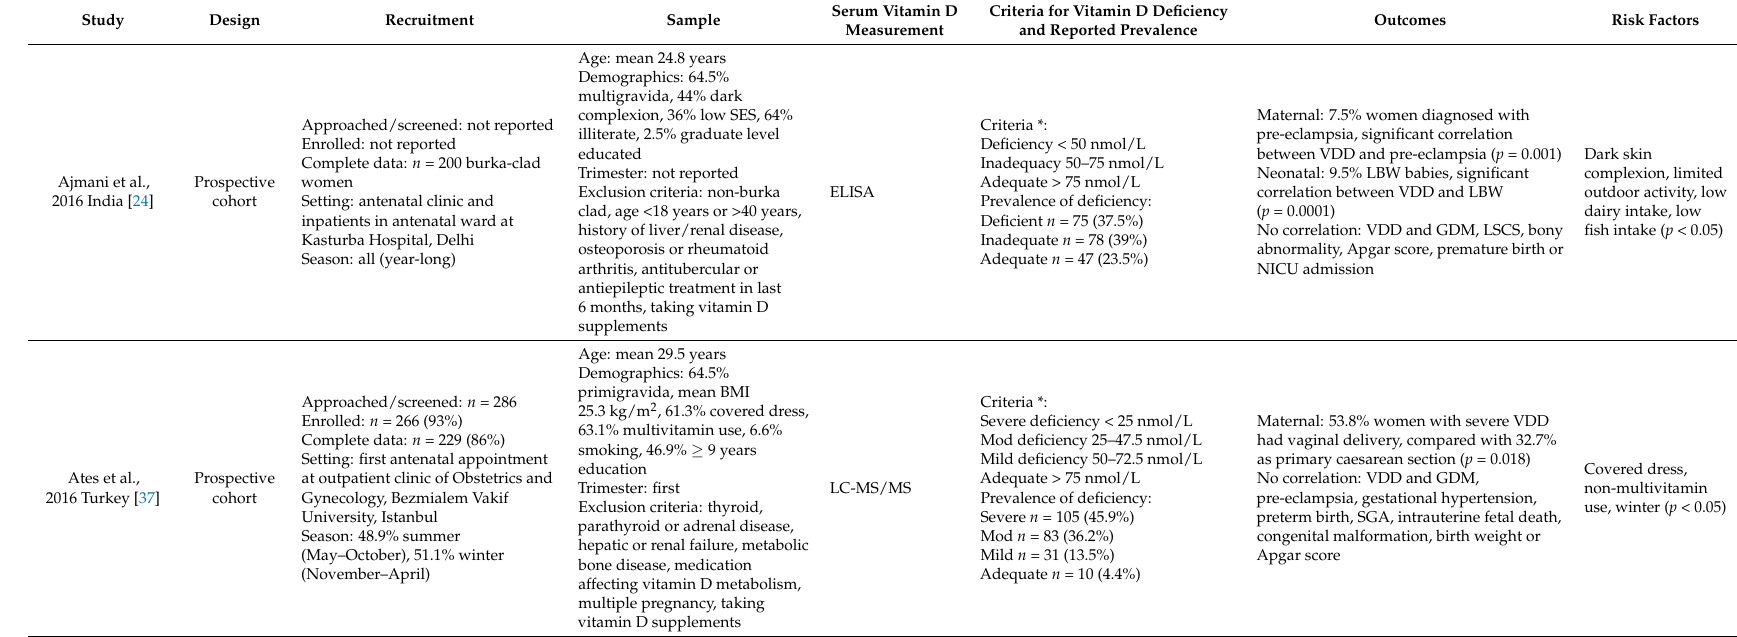
Table 1. Description of included